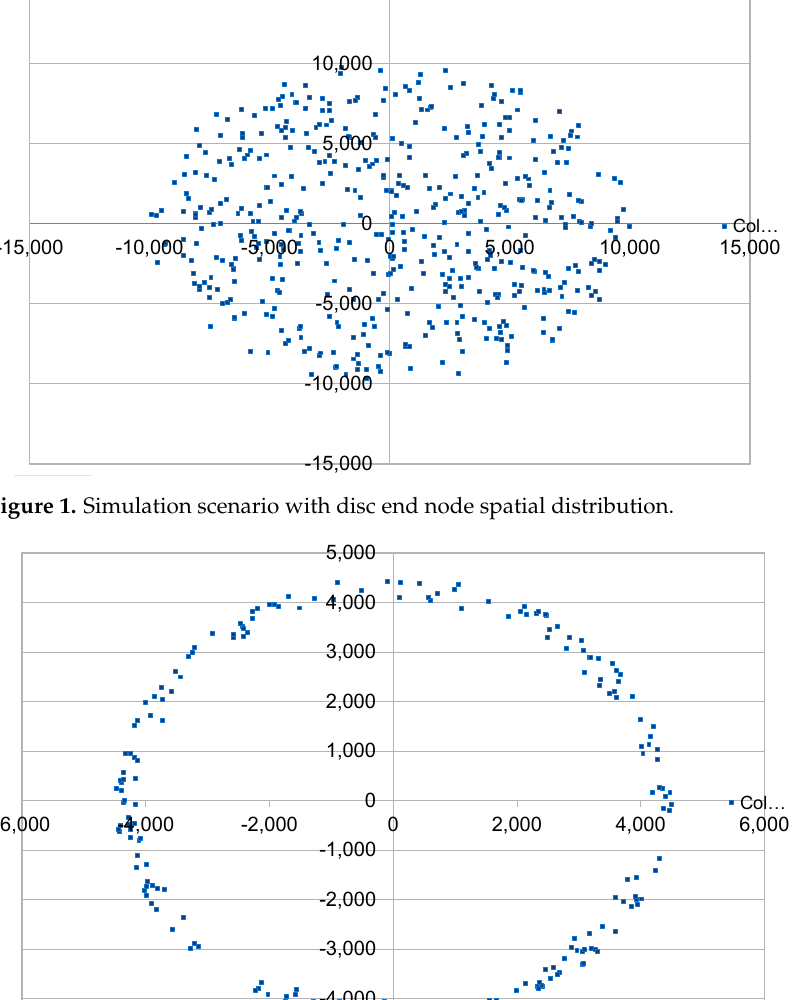
Figure 3. Simulation scenario with multiple rings end node spatial distribution. We will use packet delivery ratio (PDR) to make our assessment and to argue on the causality between observations on the communication performance of LoRaWAN. Our experiments include four different dependent variables. These variables are expressing different message transmission failure reasons. All of these dependent variables affect the overall network performance, which is measured in PDR, which is calculated from the total received packets divided by the total packets sent. In our simulations the packets that